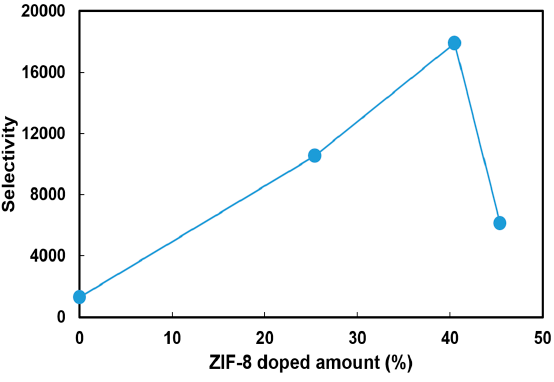
Figure 6. Selectivity (ratio of ionic conductivity to methanol permeability) of PVA and PVA/ZIF-8 membranes at 30 °C.